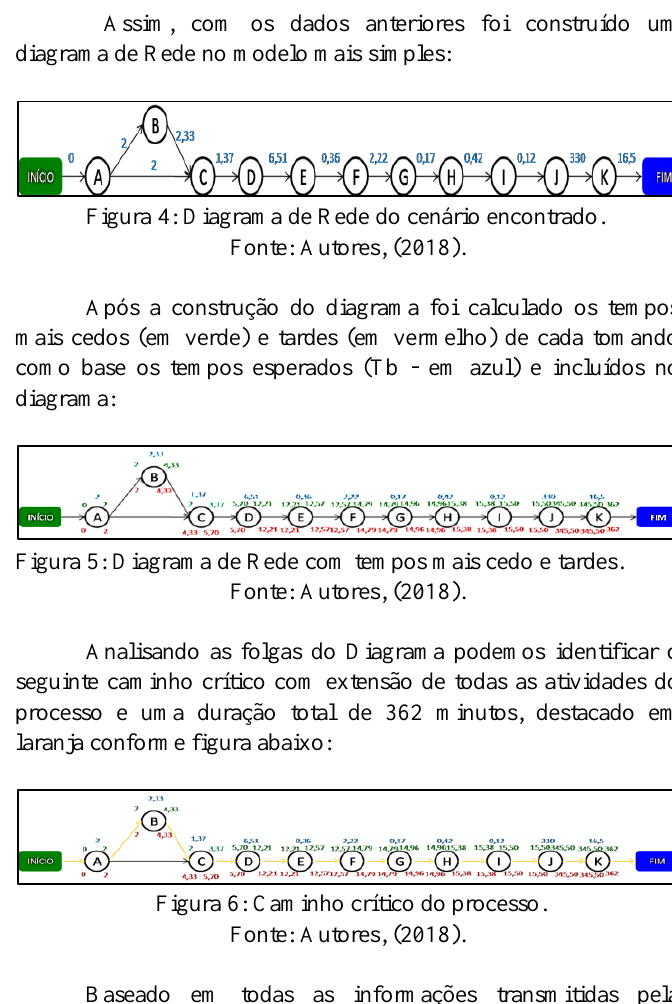
Fonte: Autores, (2018).